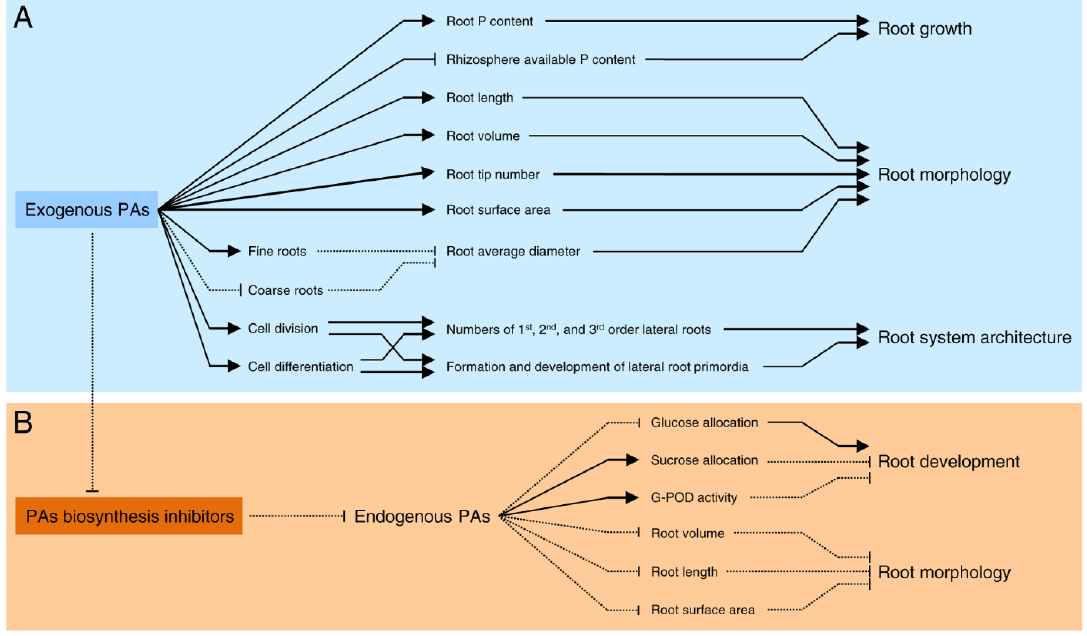
Figure 3. Hypothetical model of the e ff ect of ( A ) exogenous polyamines (PAs) and ( B ) PAs biosynthesis inhibitors on root growth, development, morphology and root system architecture of citrus plants. Solid lines with arrows signify positive reaction, while round-dotted lines with bar-ends indicate negative interaction. For more details, see the main text.